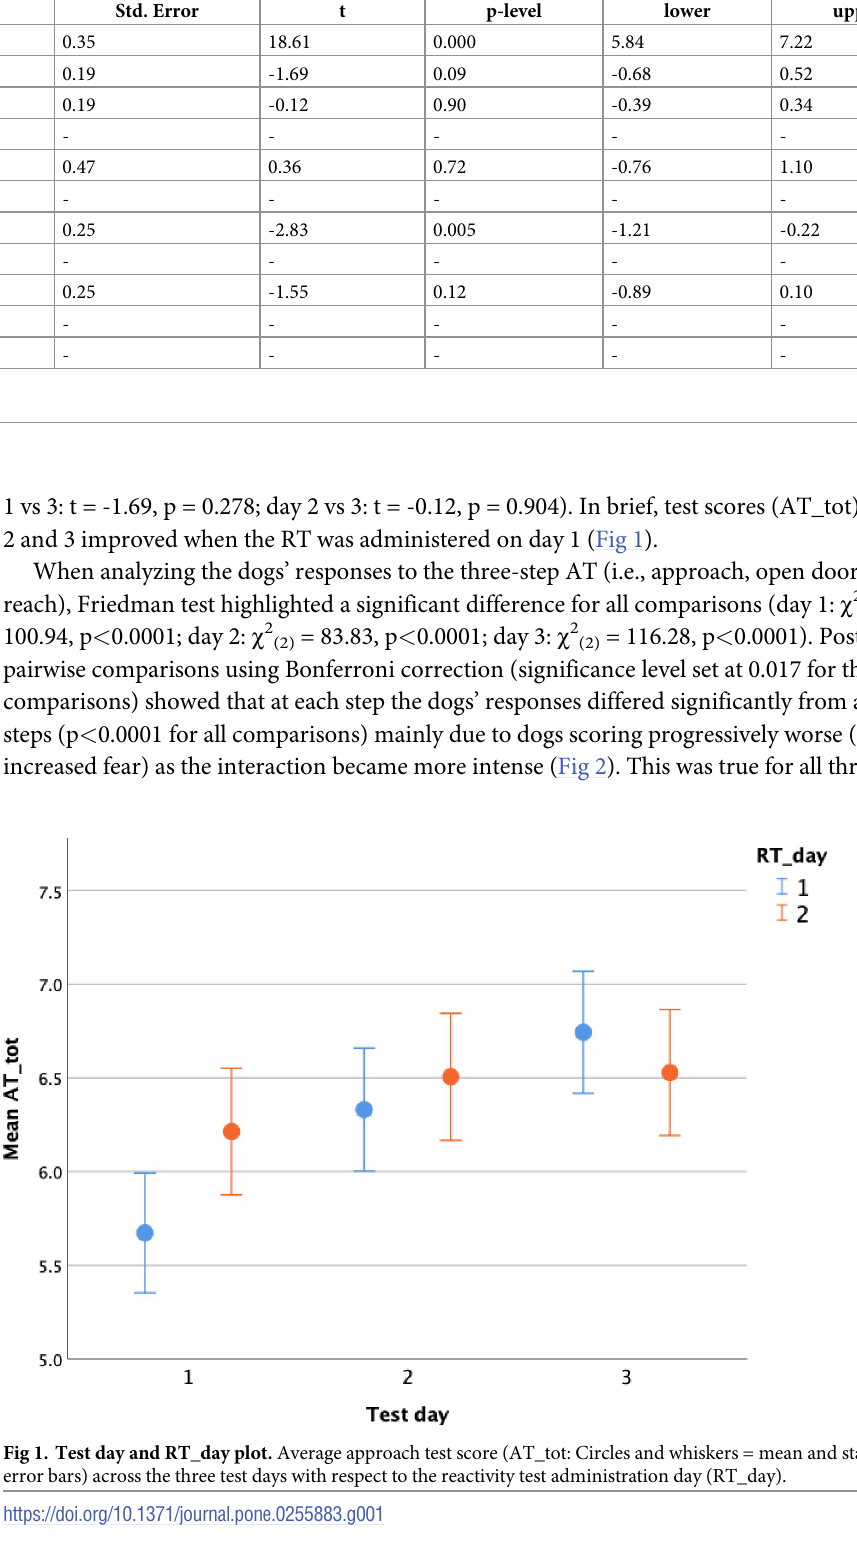
Table 4. Linear Mixed Model output. Estimates of fixed effects (i.e., day, reactivity test day (RT_day) and their interaction) on the approach test total score (AT_tot). Fixed Effect